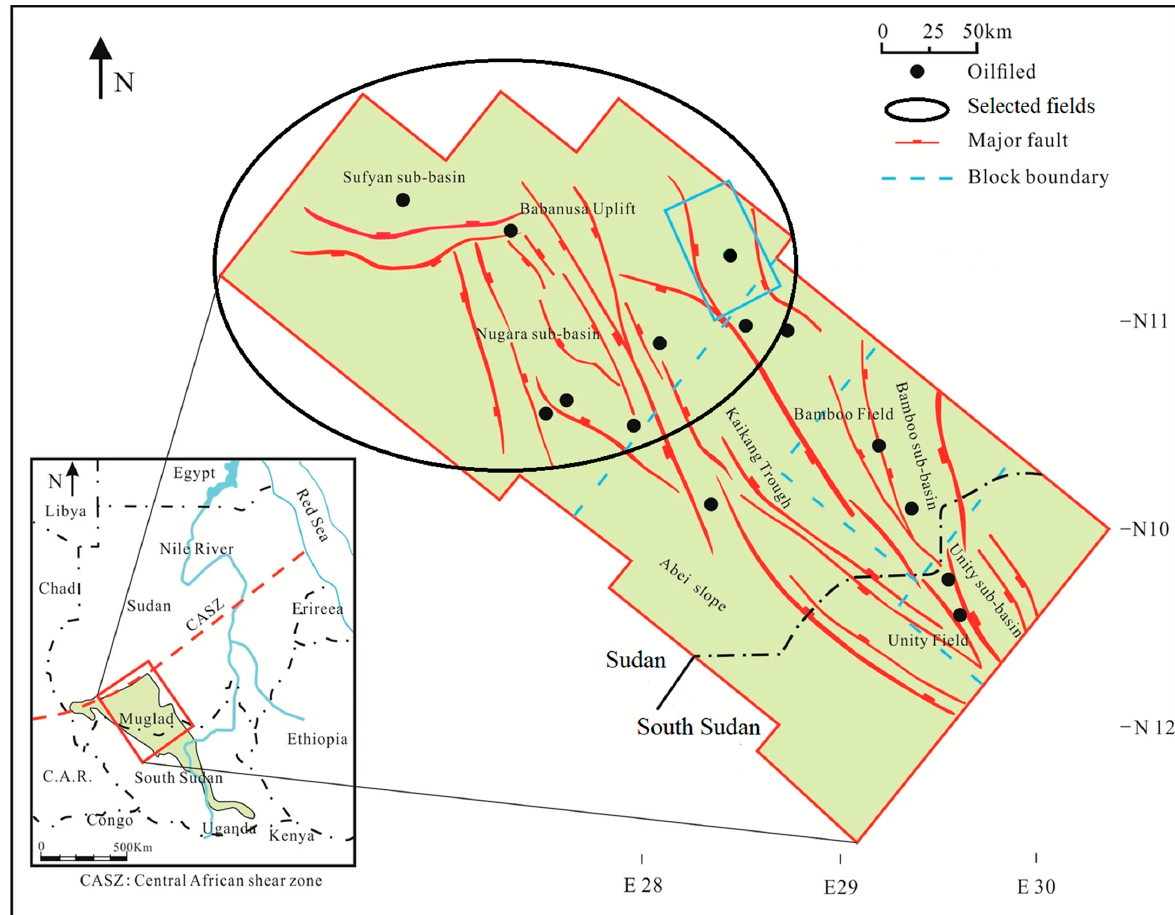
Figure 1. Muglad basin modi fi ed from [13], the selected fi eld is the upper block.